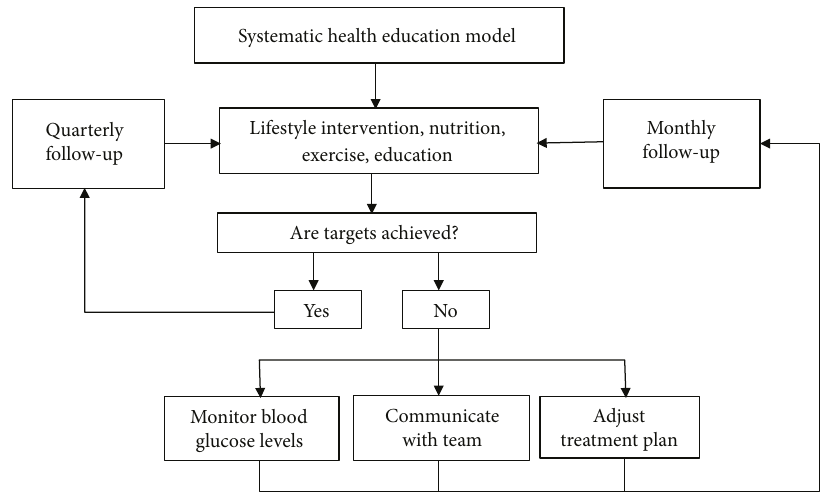
Figure 3: Flow diagram of systematic health education